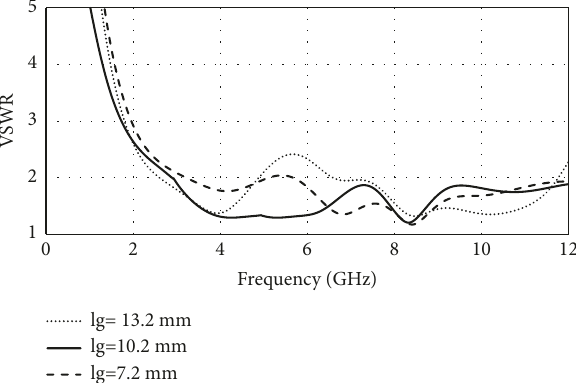
Figure 4: Simulated VSWR by varying the length of the ground